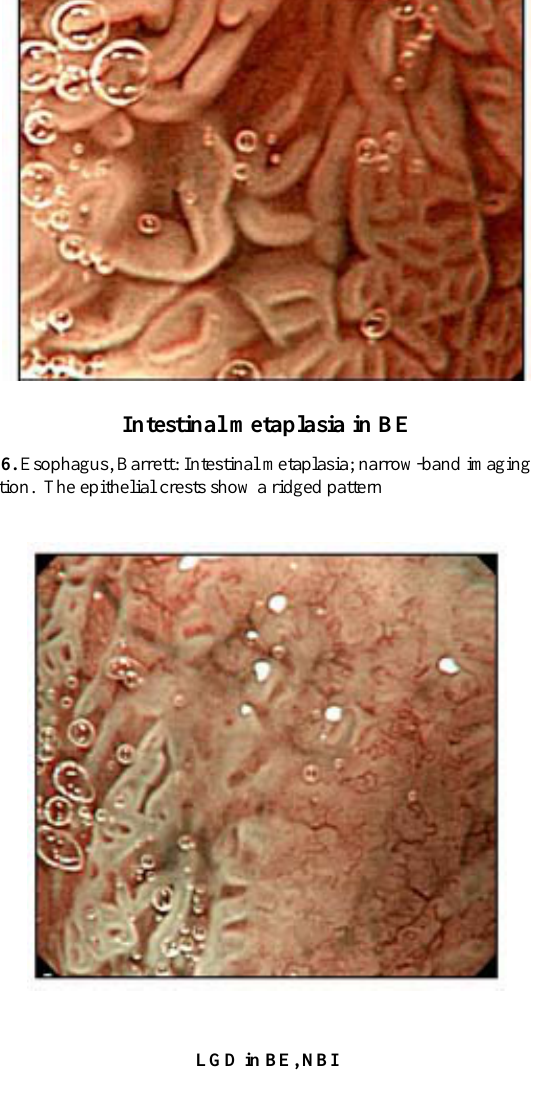
FIGURE 7. Esophagus, Barrett: narrow-band imaging coupled to magnification. Left of the image; intestinal metaplasia with a ridged pattern. Right of the image. low-grade dysplasia in a zone with an amorphous appearance and an increased visibility of small dark brown